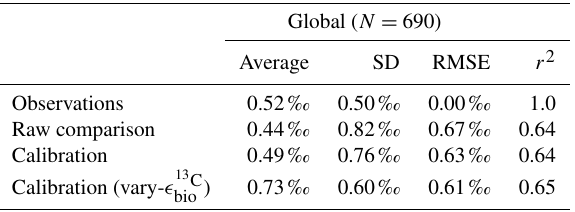
Table 3. Statistical comparison of core-top δ 13 C Cib with predicted values produced by the CSIRO Mk3L-COAL ocean